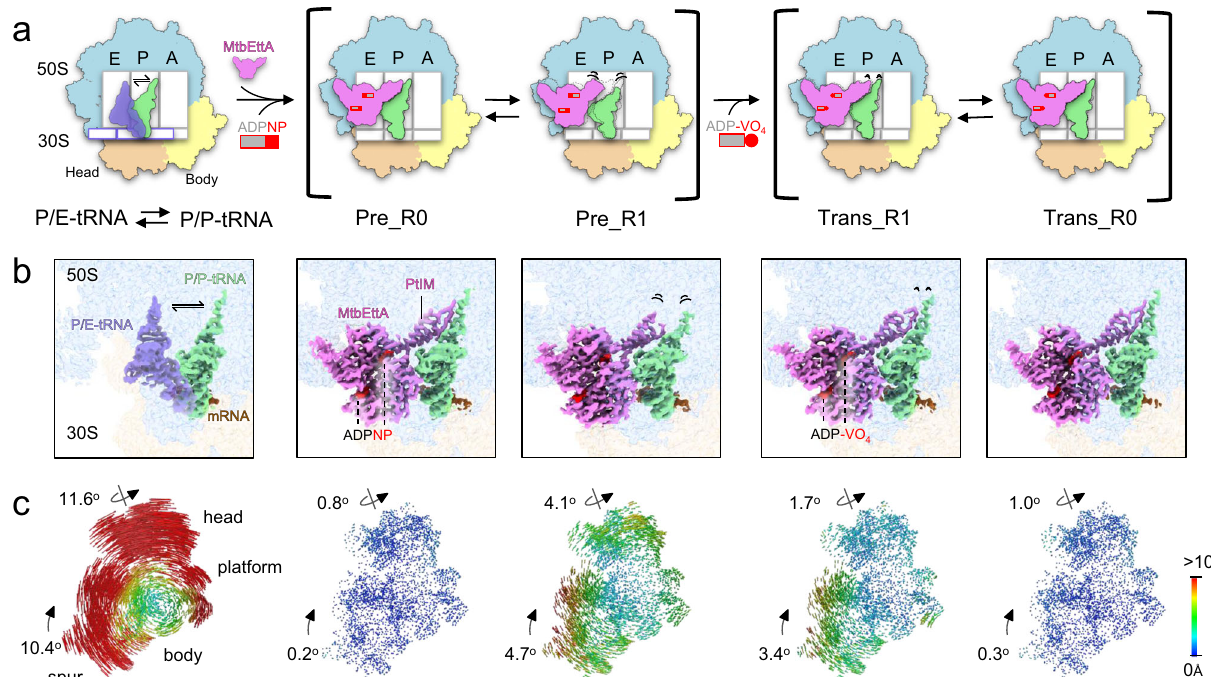
Fig. 1 Cryo-EM structures of Mtb 70SIC in complex with MtbEttA in the pre-hydrolysis and transition states. a Cartoon representations of Mtb ribosome in different states, labeled with the E, P, and A sites, as well as the 50S and domains (head and body) of the 30S. The fi rst column shows the transition of tRNA between the P/P (light green) and P/E (transparent medium blue) positions. The second and third columns show that MtbEttA (violet), in the Pre_R0 and Pre_R1 states, respectively, binds at the E-site of Mtb 70SIC and interacts with the P-site tRNA. The fourth and fi fth columns show the corresponding 70SIC-MtbEttA complexes in the Trans_R1 and Trans_R0 states, respectively. Dashed outlines at the E and P sites (third column) show the position of MtbEttA and the tRNA in the Pre_R0 state. The length of the black curved lines indicates the fl exibility in these regions. b Cryo-EM maps showing the density of tRNAs and MtbEttA with the 50S (light blue) and the 30S (light yellow) transparent in the background. PtIM and ATP analogs are labeled. The color scheme follows panel ( a ). c Analysis of 30S rotations in the P/E-tRNA or MtbEttA-bound states, relative to the non-rotated P/P-tRNA state. The head, body, platform, and spur of the 30S subunit are labeled. Rainbow-colored vectors represent the displacements between equivalent C4 ’ or C α atoms of the 30S subunits, with red and blue indicating large and small movements,